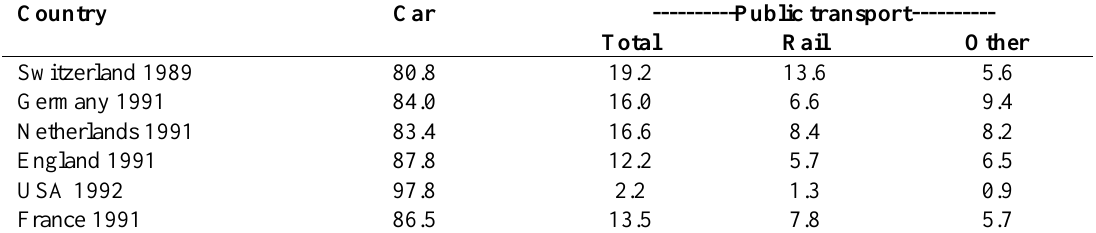
Table 6. Modal split passenger transport (in %, excluding biking and walking)